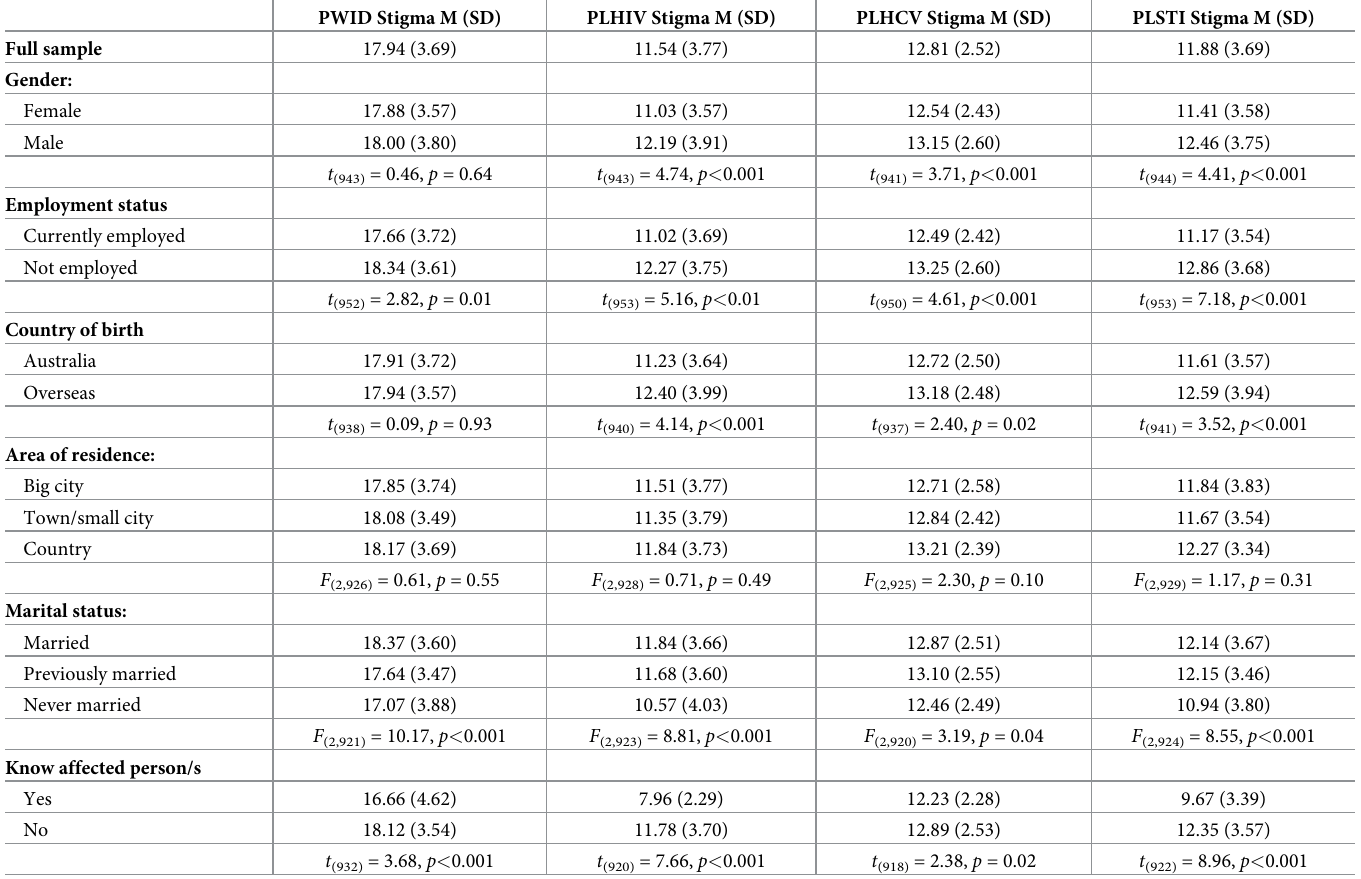
Table 2. Comparison of mean people who inject drugs, people living with HIV, people living with hepatitis C, and people living with sexually transmissible infec- tions stigma scale scores between socio-demographic groups.